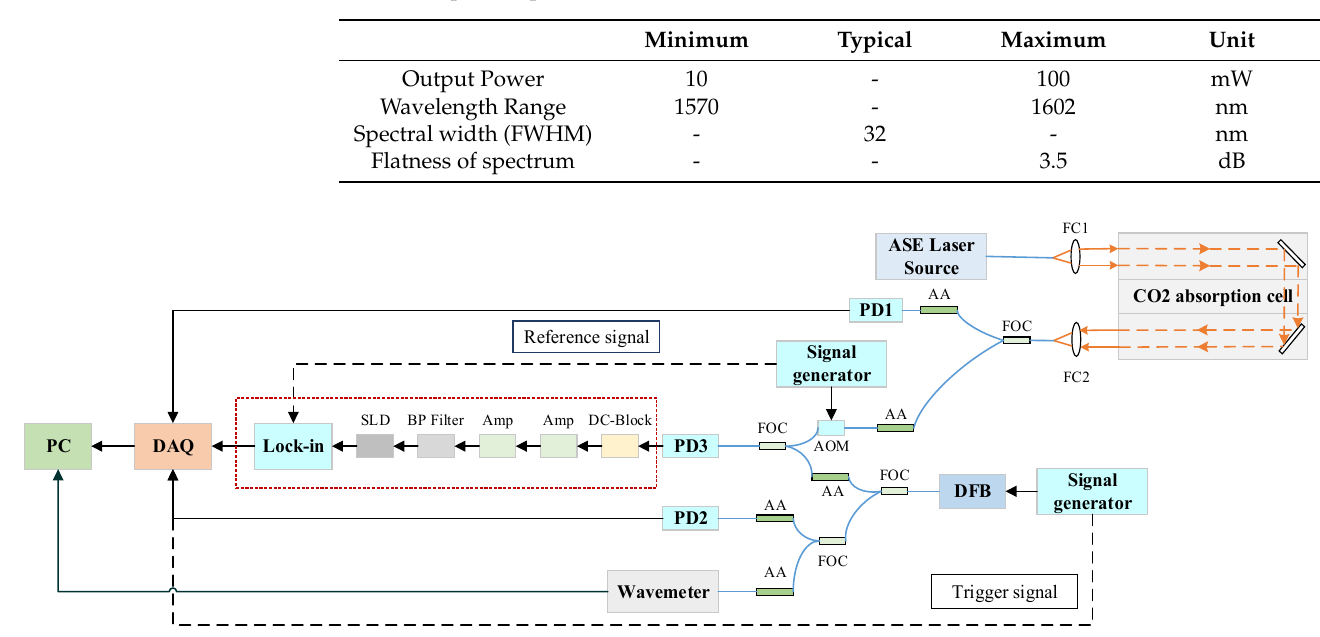
Table 1. Important parameters of ASE source.